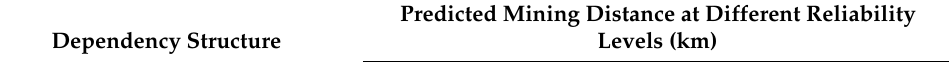
Table 13. Predicted mining distances (unit: km) under different copulas, independent conditions, and marginal